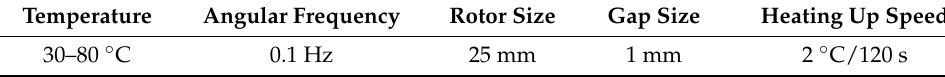
Table 4. DSR high-temperature scanning parameter setting table.